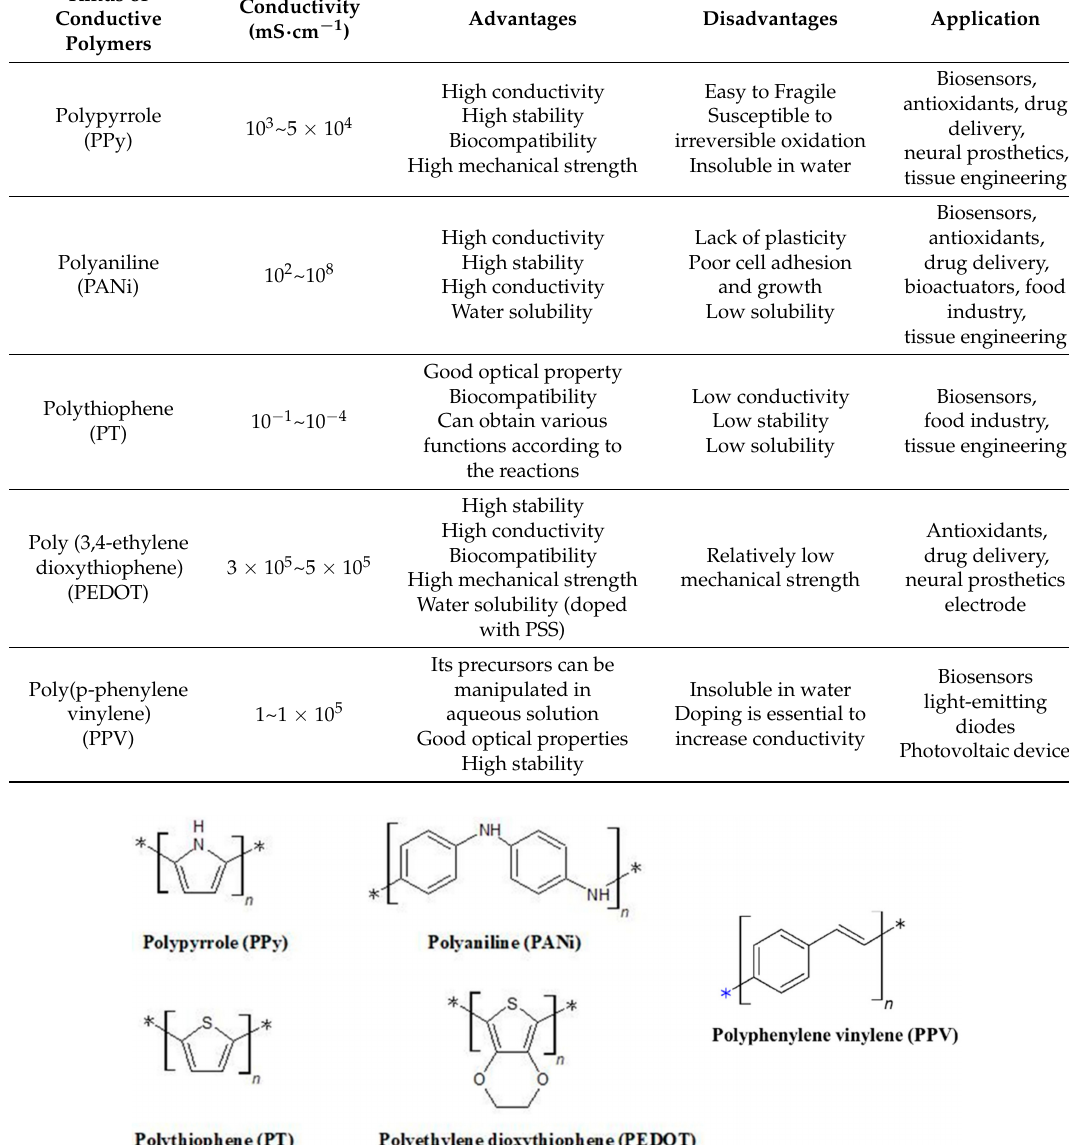
Figure 3. Chemical structures of various conductive